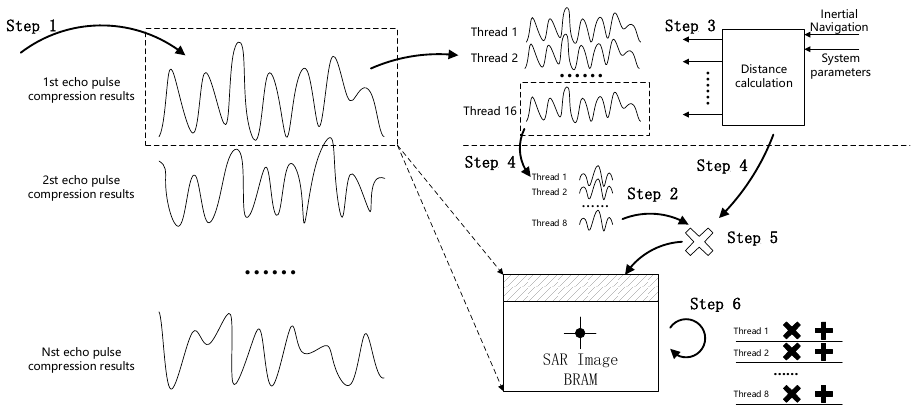
Figure 12. Parallel implementation process.